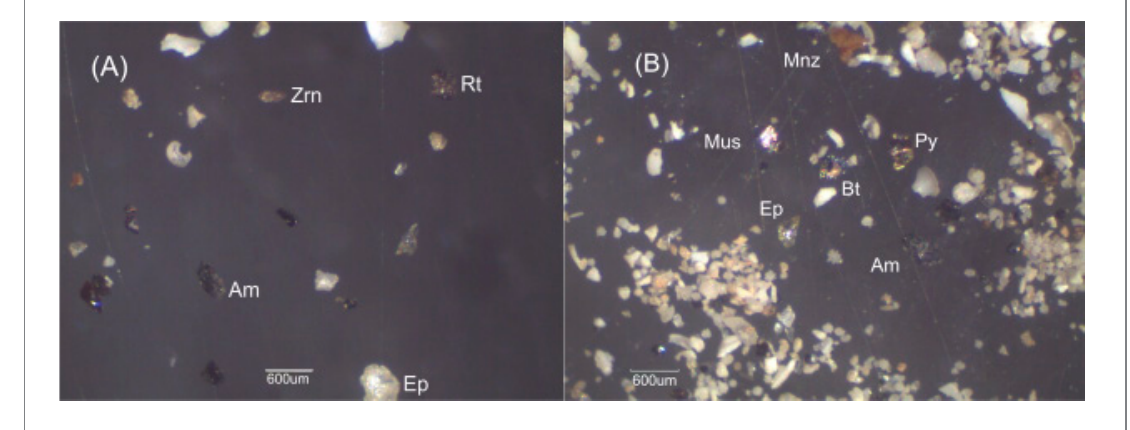
Figure 5 - (A): Heavy minerals at 0-3 cm depth-SIS-454. Zrn-zircon, Rt-rutile, Am-amphibole, Ep-epidote. (B): Heavy minerals at 10-14 cm at SIS-454. Mnz-monazite, Mus-muscovite, Bt-biotite, Ep-epidote, Py-pyrite, Am-amphibole. Acronyms according to the Subcommittee on the Systematics of Metamorphic Rocks by IUGS. The scale bar corresponds to 600 μm.